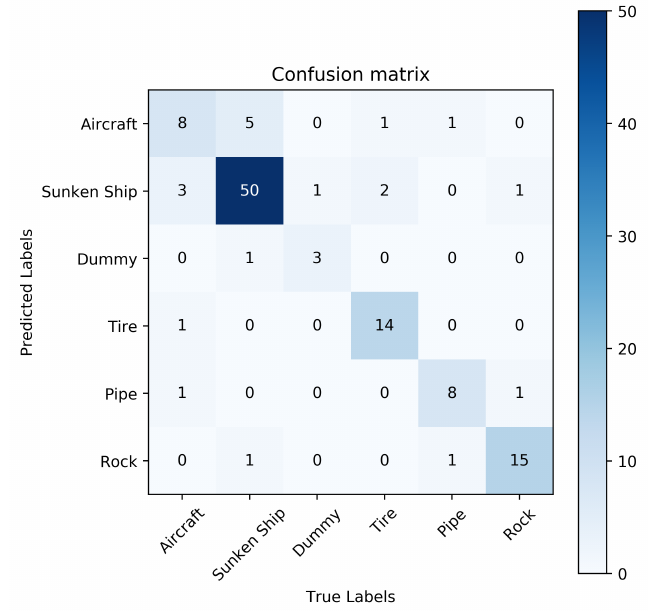
Figure 17. ResNet-ACW+GAN+FL.